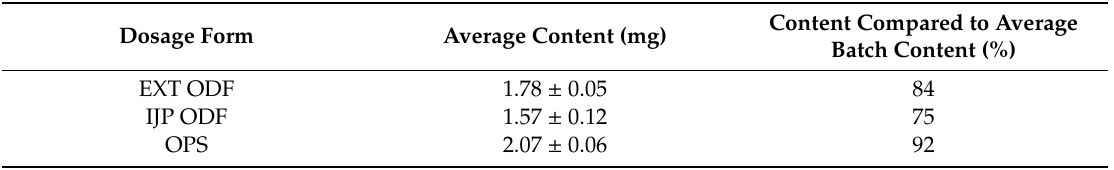
Table 6. Content of warfarin sodium passing through the naso-gastric tube after dissolving / dispersing the di ff erent dosage forms in 2 mL of water. Results presented as the average ± SD, n = 3. Dosage